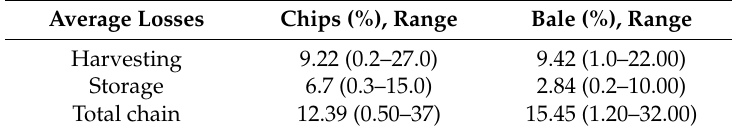
Table 6. Summary of average biomass losses for identified PtE value